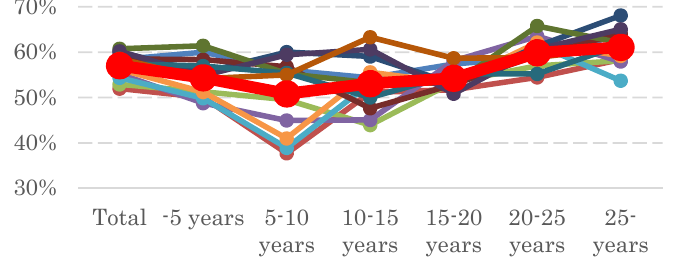
Figure 2. Years of service and “yes” percentage of P1